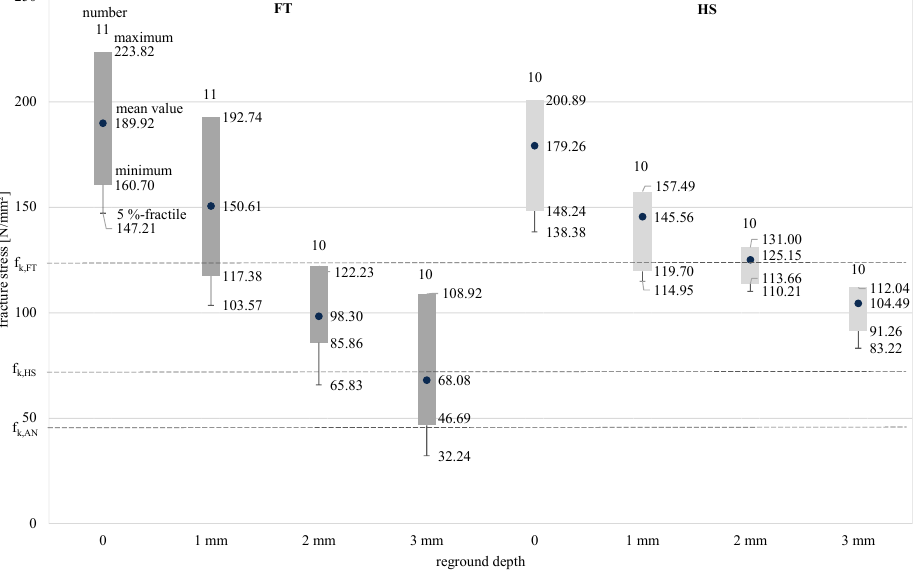
Fig. 10 Evaluation of the experimental